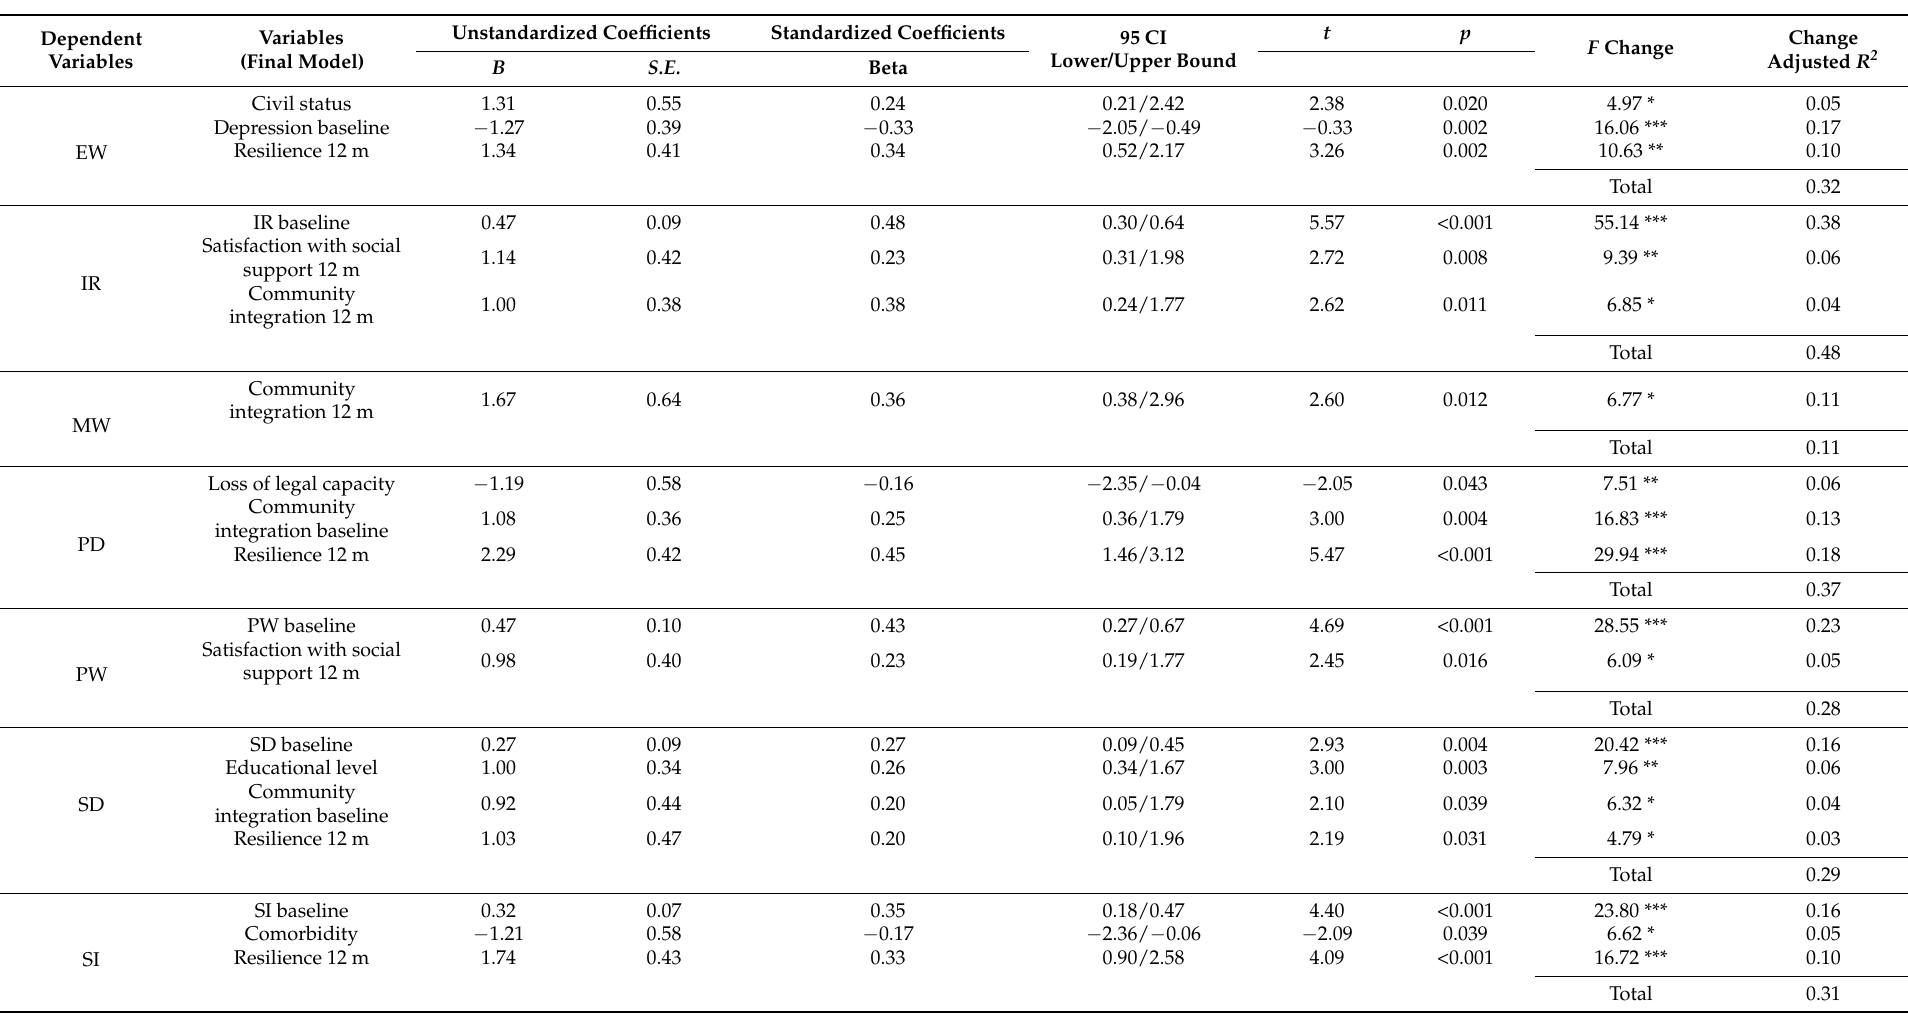
Table 5. Results from the hierarchical regressions models of QoL domains and total